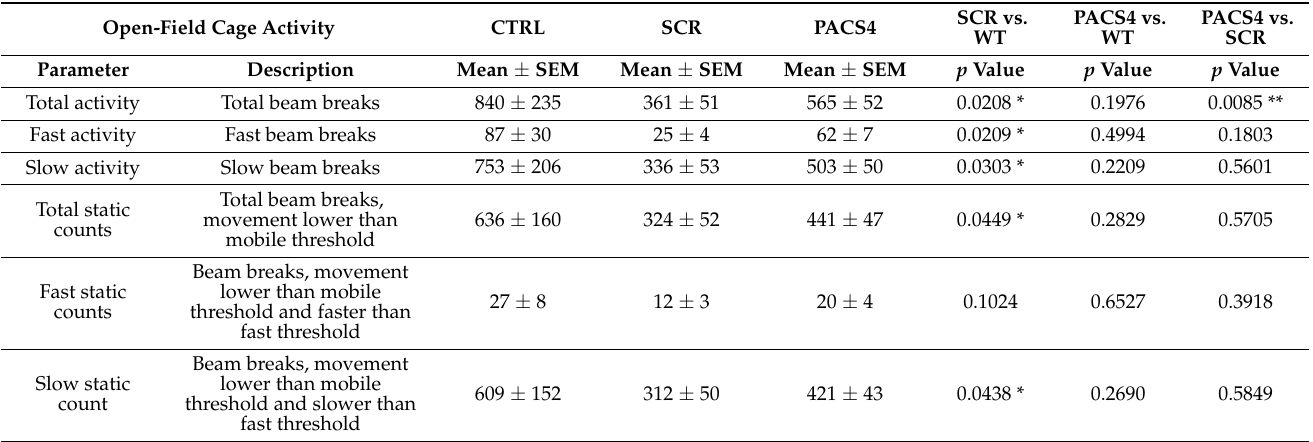
Table 2. Changes in mouse locomotor behavior after longitudinal vivoPMO